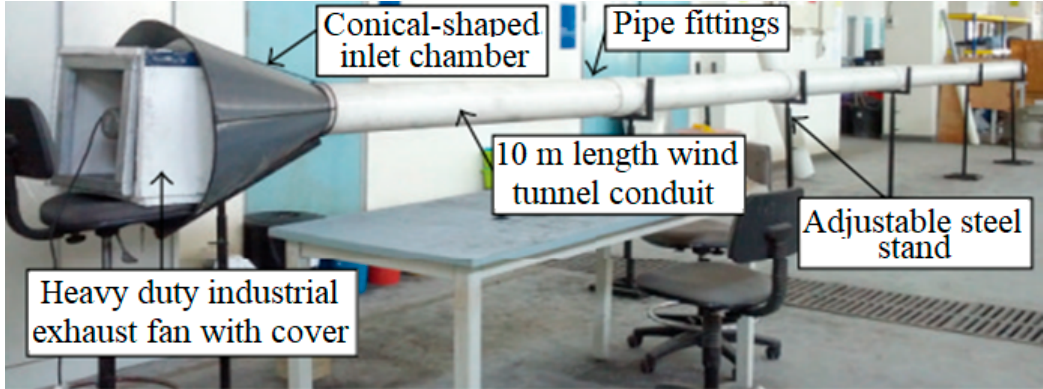
Figure 5. Right-side-view of the setup of wind tunnel manufacturing scheme [43]. Reprinted with permission from Ahmadi et al. [43].